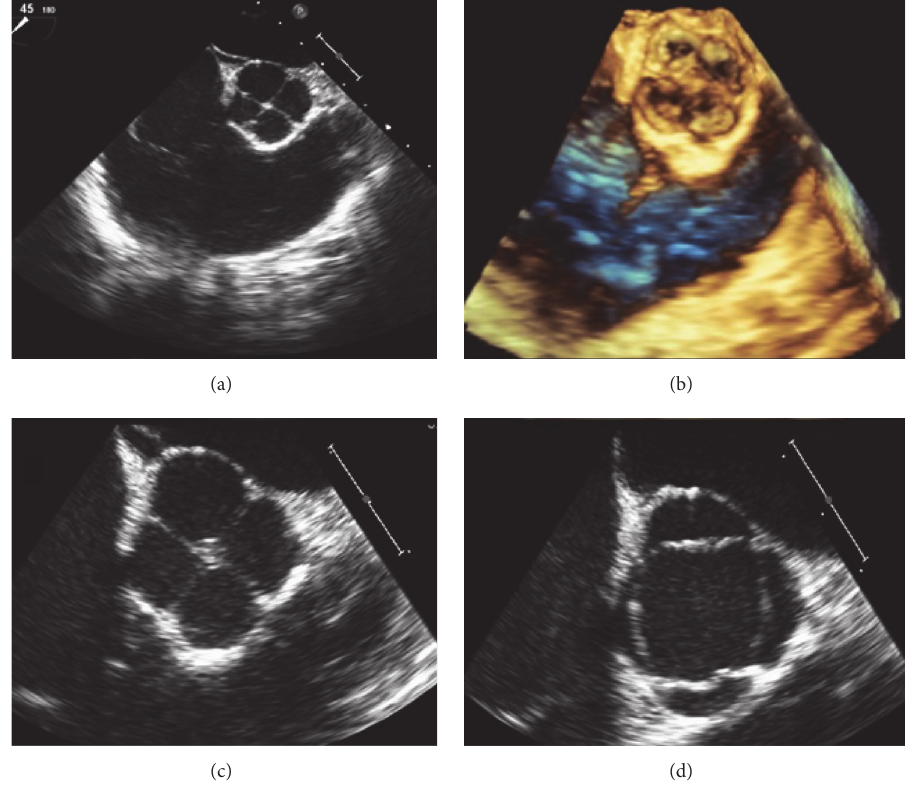
Figure 1: Transesophageal echocardiogram short axis view of the aortic valve revealing QAV. (a) 2-dimensional and (b) 3-dimensional view of the same image. (c) and (d) showing the zoomed view of the short axis QAV in diastole and systole, respectively.